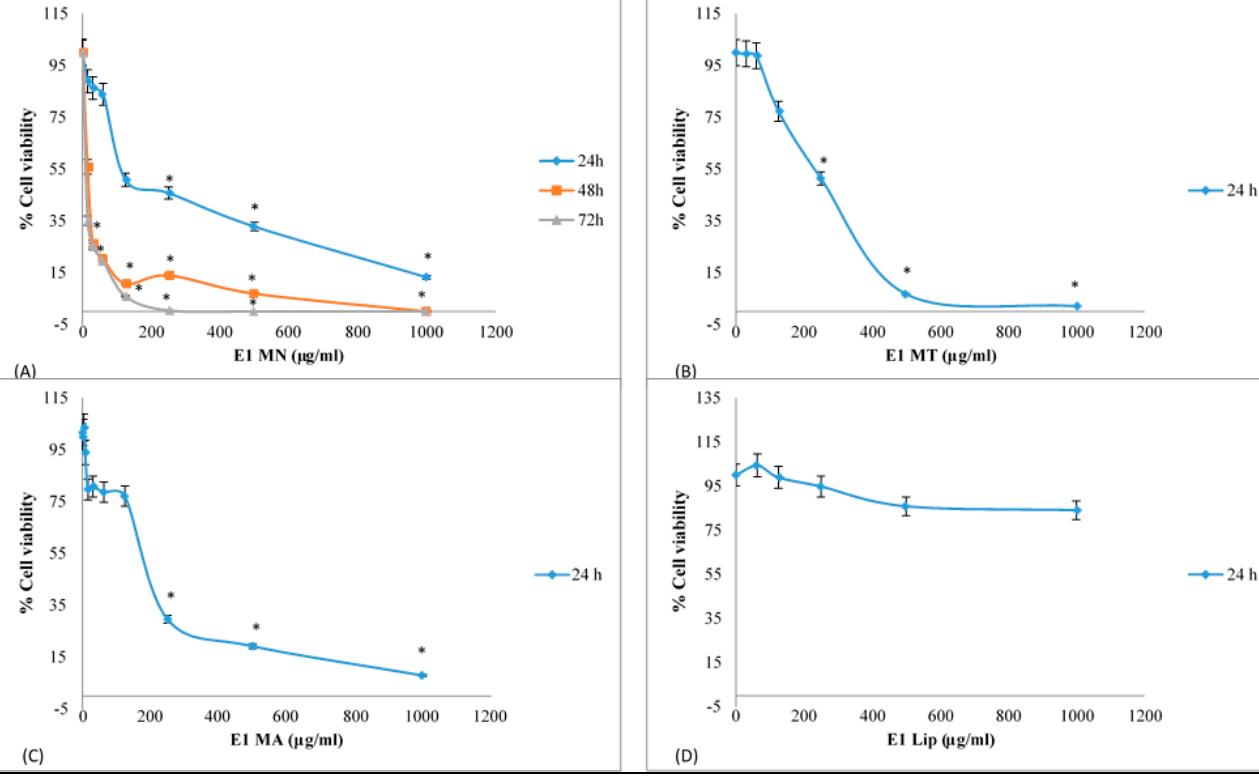
Figure 3. Dose–effect survival plots for mastic extracts against a human liver cancer HepG2 cell growth. ( A ) E1 MN: Liposomes contained NMGE, ( B ) E1 MT: Liposomes contained total mastic gum, ( C ) E1 MA: Liposomes contained AMGE, and ( D ) E1 Lip: Empty liposomes. Cell viability was estimated via XTT assay (each point represents mean ± sd of at least six replicate wells). * p < 0.05. The inhibitory potency of the tested extracts against HepG2 cells was according to